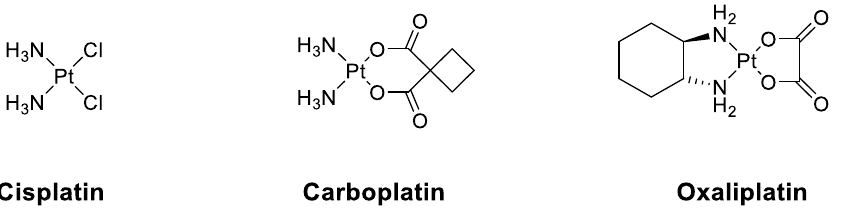
Figure 5. Structures of cisplatin, oxaliplatin, and carboplatin. 2.10. Designing New Synthetic Concepts for Imparting Molecular Complexity with C-1 Sources